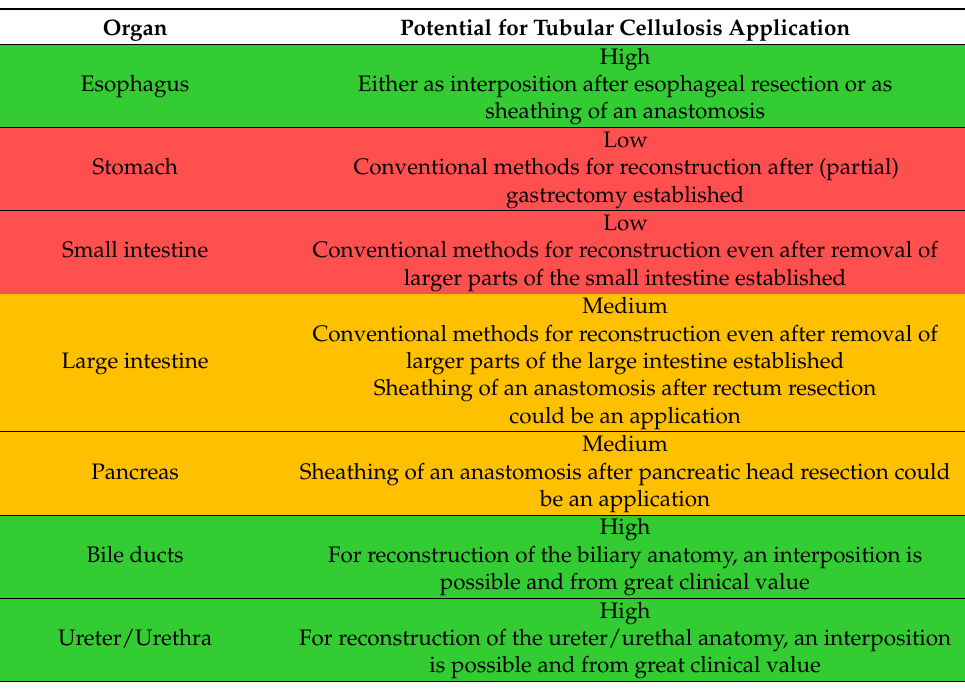
Table 1. Potential applications for biocellulose in modern abdominal surgery—a clinician’s per- spective (green: high application potential, orange: medium application potential, red: low application